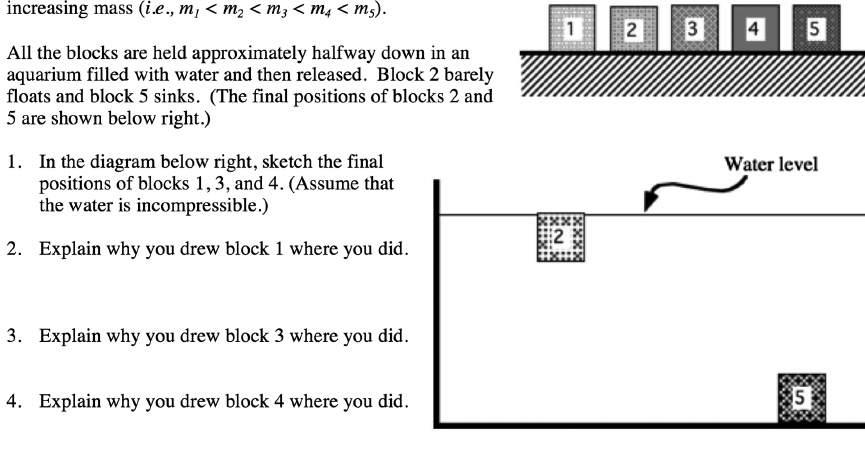
FIG. 2. The original 5-block